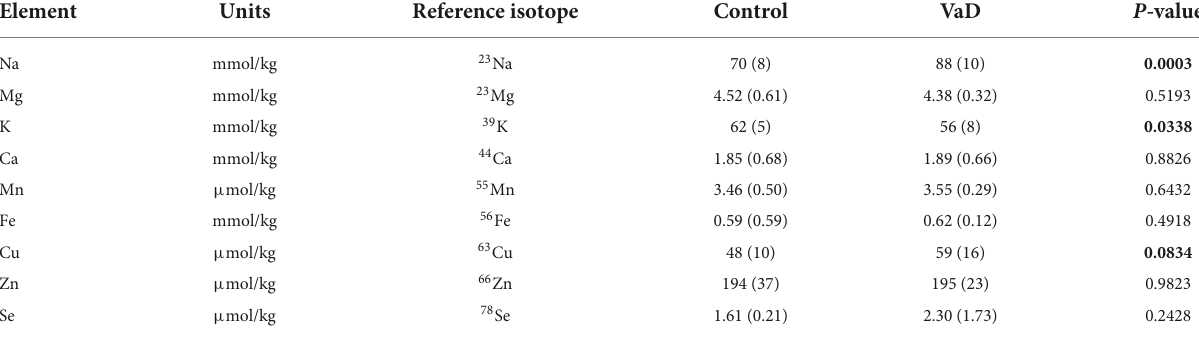
TABLE 9 Wet-weight metal concentrations in the cingulate gyrus of VaD and control brains. Element